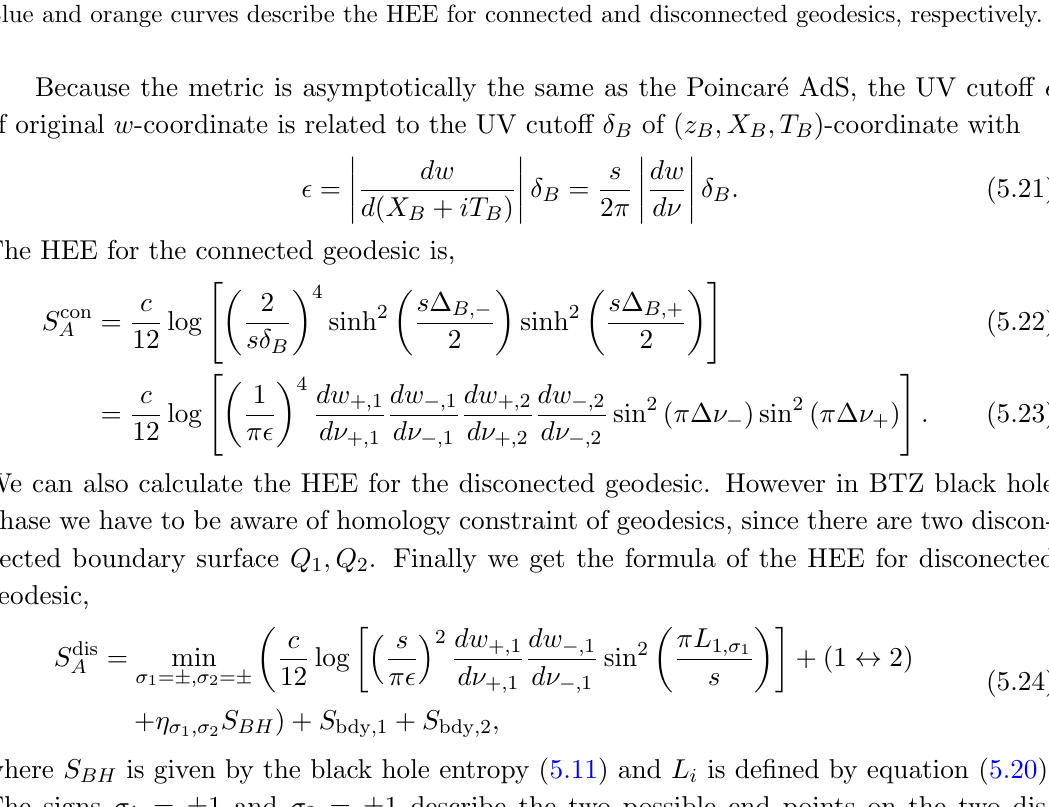
Figure 37 . The time evolution of HEE in thermal AdS phase. The horizontal axis describes the time t , and the vertical axis describes (cid:1) S A . We set b = 50 and a = 50 (this corresponds to s = 0 : 945 : : : ( < 1)), and the subsystem A is chosen to be (i), (ii), (iii) and (iv). The upper left graph is for (i), the upper right is for (ii), the lower left is for (iii), and the lower right is for (iv). Blue and orange curves describe the HEE for connected and disconnected geodesics,